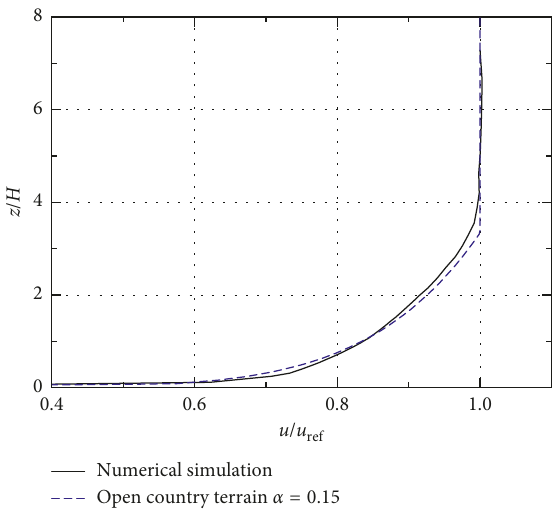
Figure 1: Vertical profile of the mean velocity at the inlet boundary.